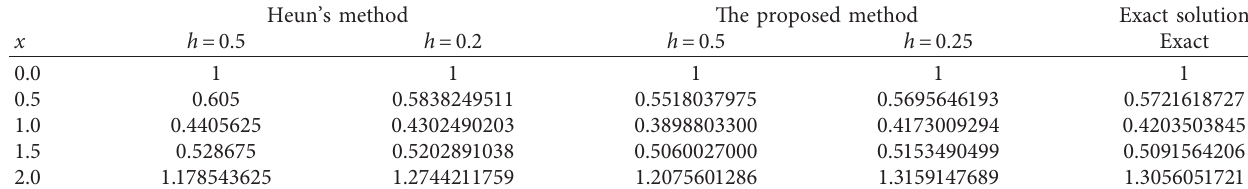
Table 5: Numerical solutions and exact solution for Example 3.